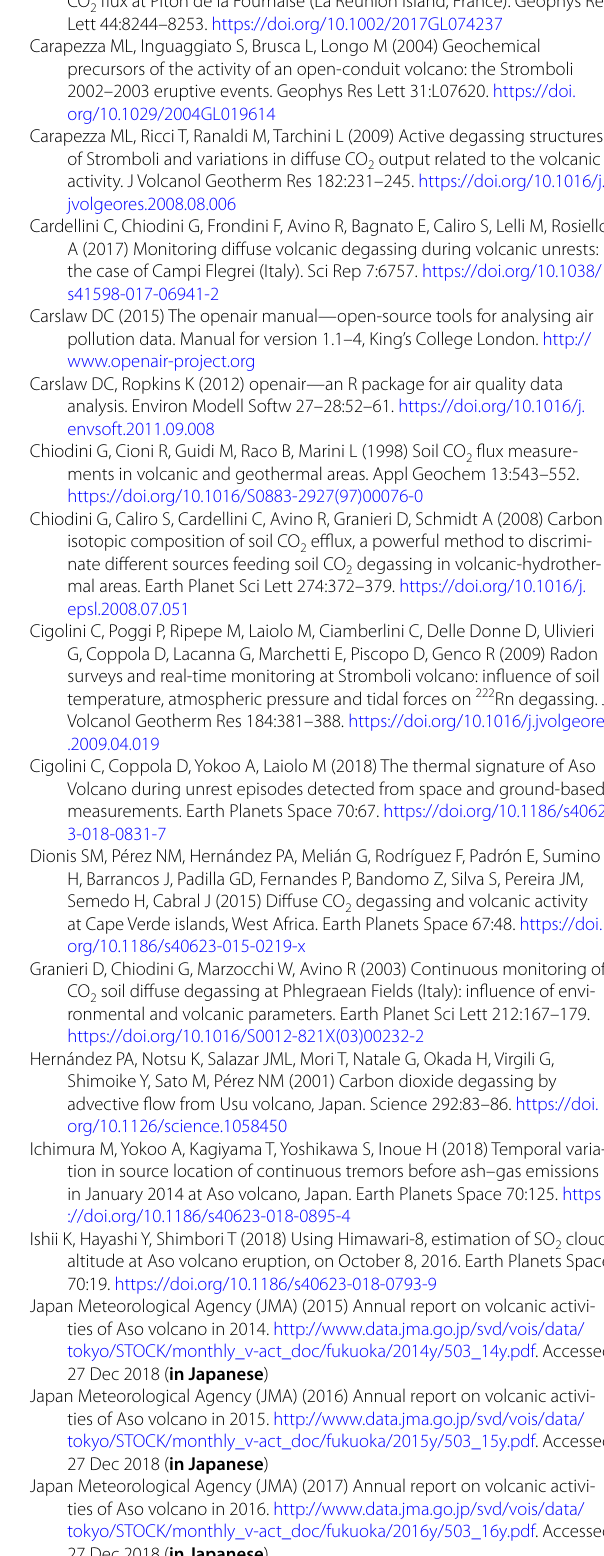
and the weather station. Figure S3. A histogram of soil CO 2 flux and cor‑ relation plots of soil CO 2 flux to each environmental parameter. Table S1. Technical characteristics of the soil CO 2 flux